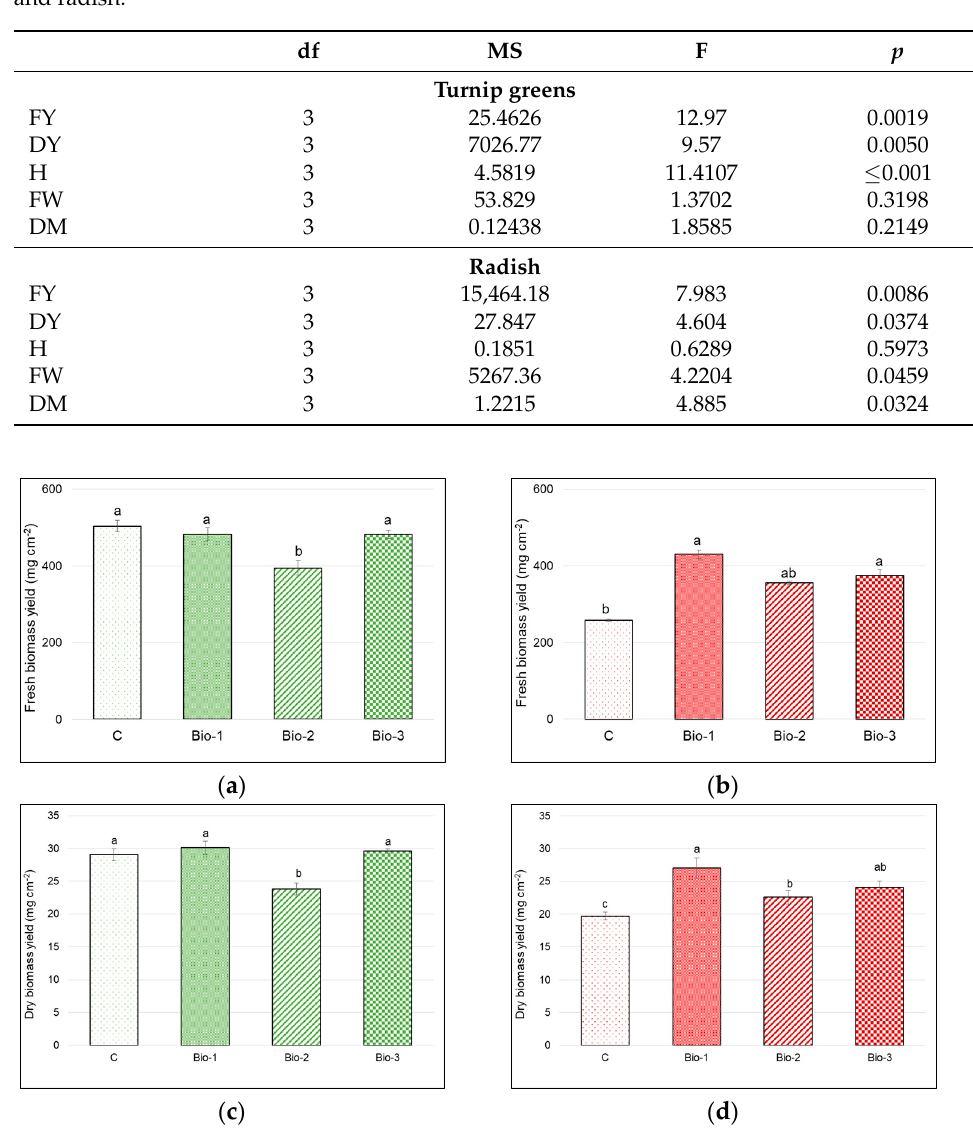
Table 1. Results of one-way ANOVA for fresh (FY) and dry biomass yield (DY), seedling height (H), seedling fresh weight (FW) and seedling dry matter percentage (DM), in microgreens of turnip greens and radish.